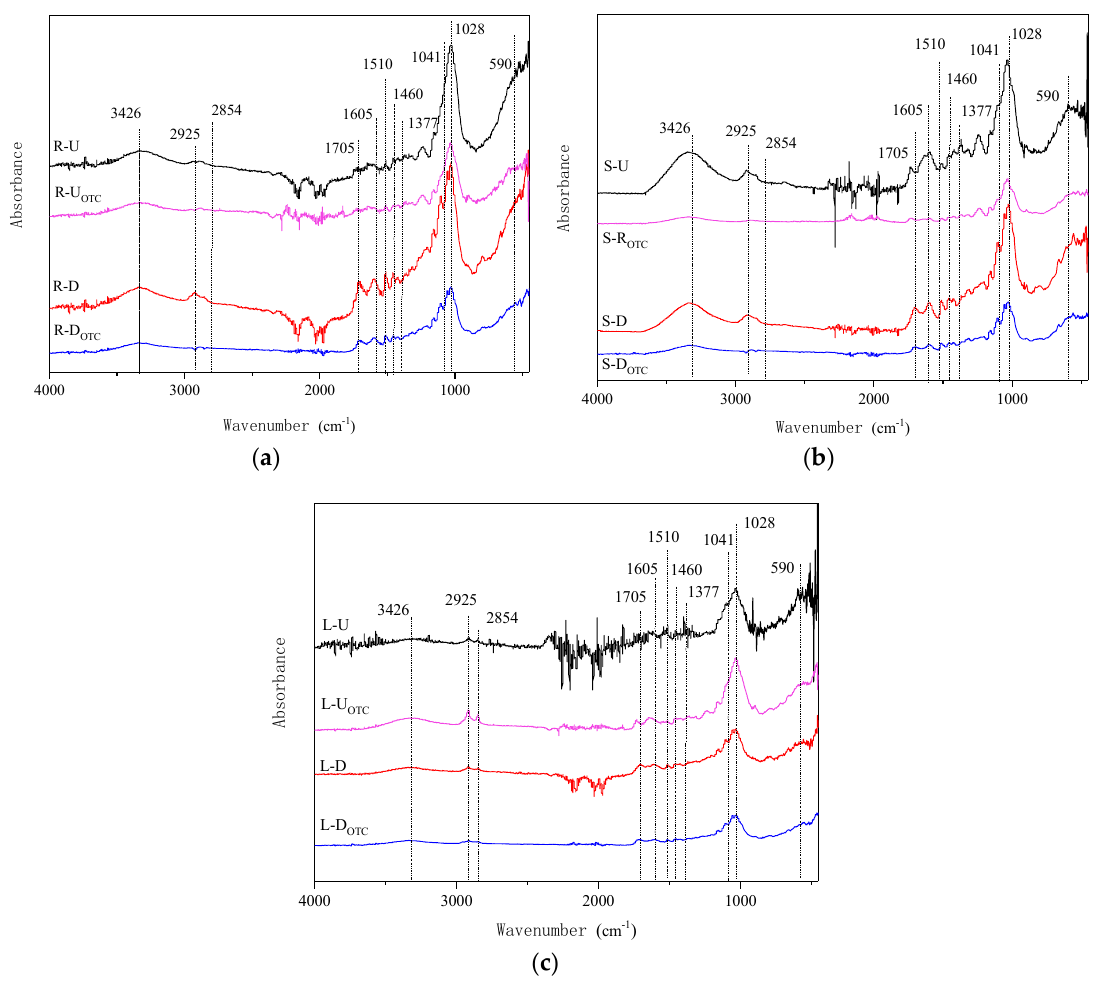
Figure 5. FTIR spectra of the reed ( a ) roots, ( b ) stems and ( c ) leaves.